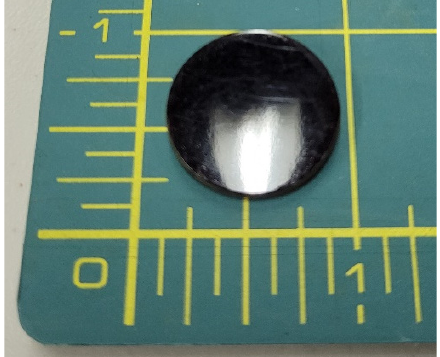
Figure 1. Photograph of poly(BAF-oda-fu) sample. Scale units are inches.